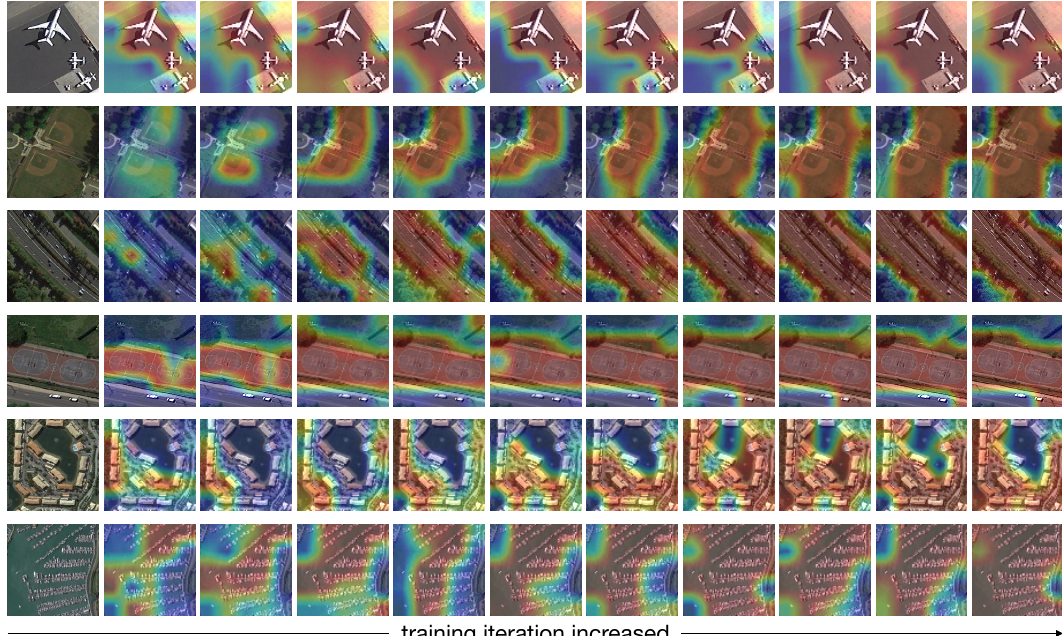
Figure 13. The class activation maps (CAMs) of images training by our self-supervised network, where the corresponding labels are: airplane, baseball diamond, freeway, basketball court, dense residential, and harbor. The training iteration increased from left to right